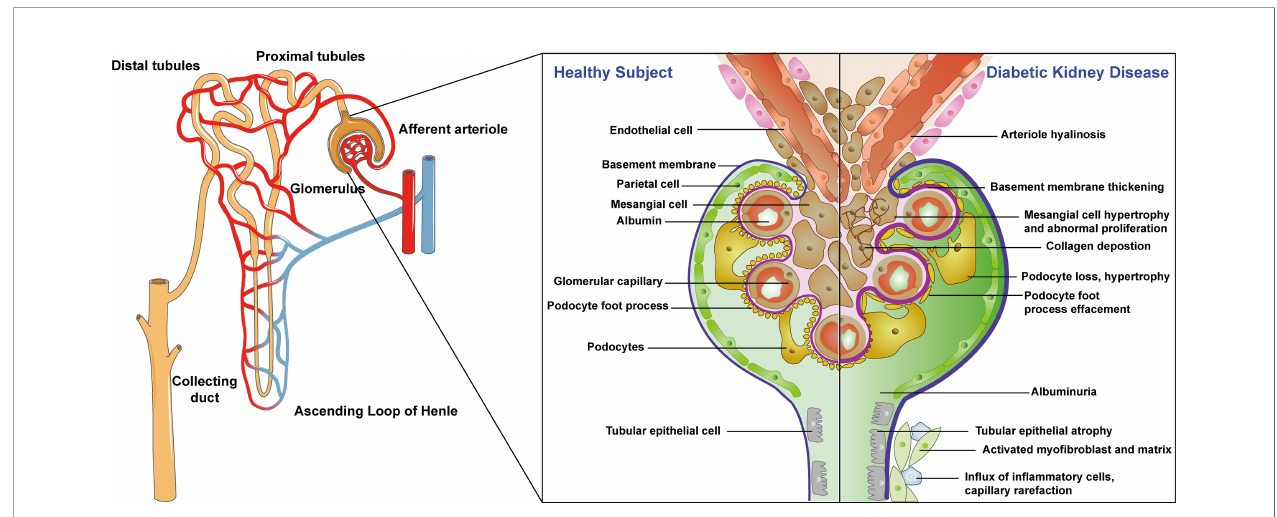
FIGURE 1 | Physiological structure of nephron and pathologic process of diabetic kidney diseases. Left: whole kidney structure; middle: healthy nephron structure; right: the pathological changes of